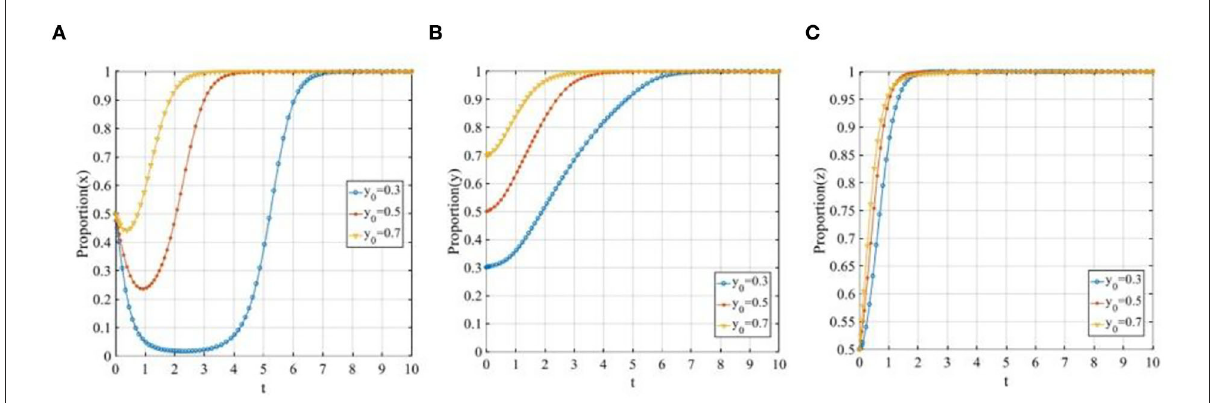
FIGURE5 The evolutionary trajectories of three participants when y 0 = 0.3, 0.5, 0.7. (A) The sensitivity of P2P lending platforms; (B) The sensitivity of investors; and (C) The sensitivity of financial regulators.